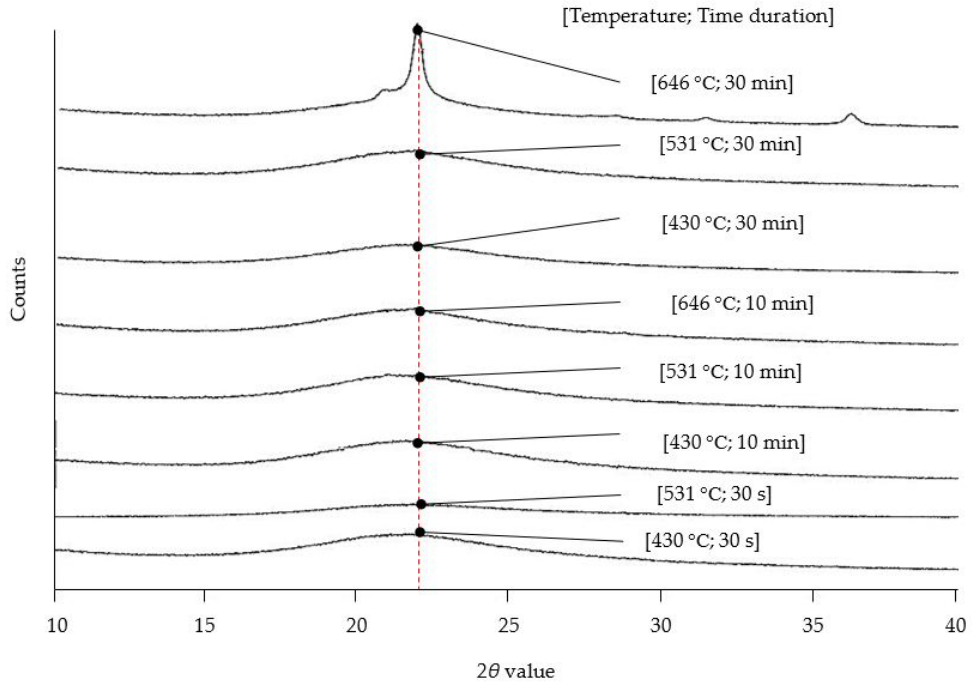
Figure 6. The XRD analysis results for rice husk charcoal under different temperatures and combus- tion time